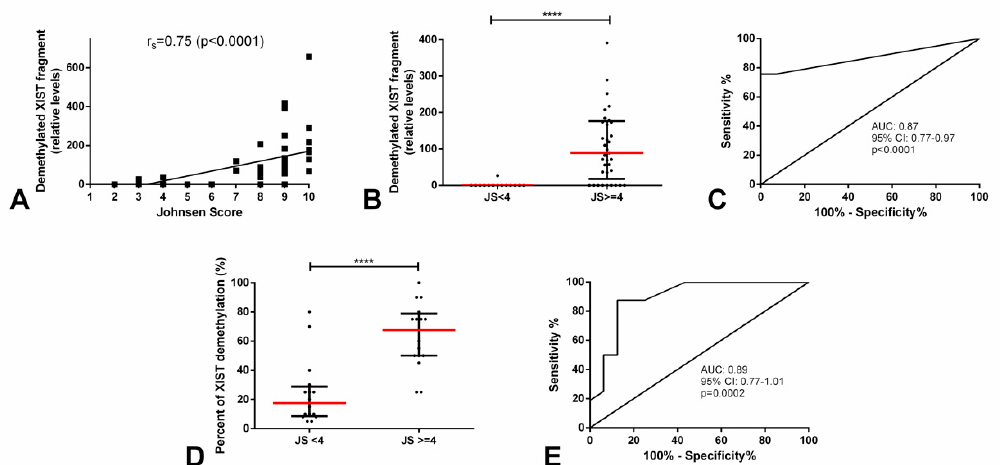
Figure 8. Demethylated XIST fragment relative amounts in testicular parenchyma with various Johnsen’s scores (discovery and validation cohorts). ( A ) Correlation between Johnsen’s score and relative amounts of demethylated XIST fragment; ( B ) relative amounts of the demethylated XIST fragment in high and low Johnsen’s score groups, respective ROC curve in ( C ); and ( D ) percentage of the demethylated XIST fragment in high and low Johnsen’s score groups, respective ROC curve in ( E ). **** indicates p < 0.0001. Abbreviations: AUC—area under the curve and JS—Johnsen’s score.